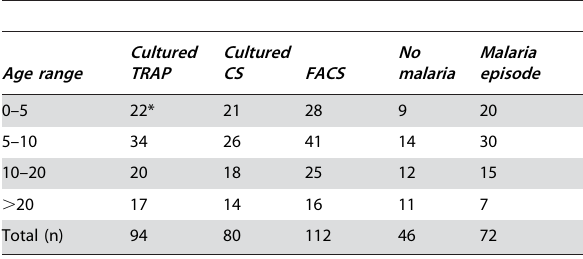
Table 1. Descriptive data on age groups tested and malaria incidence.